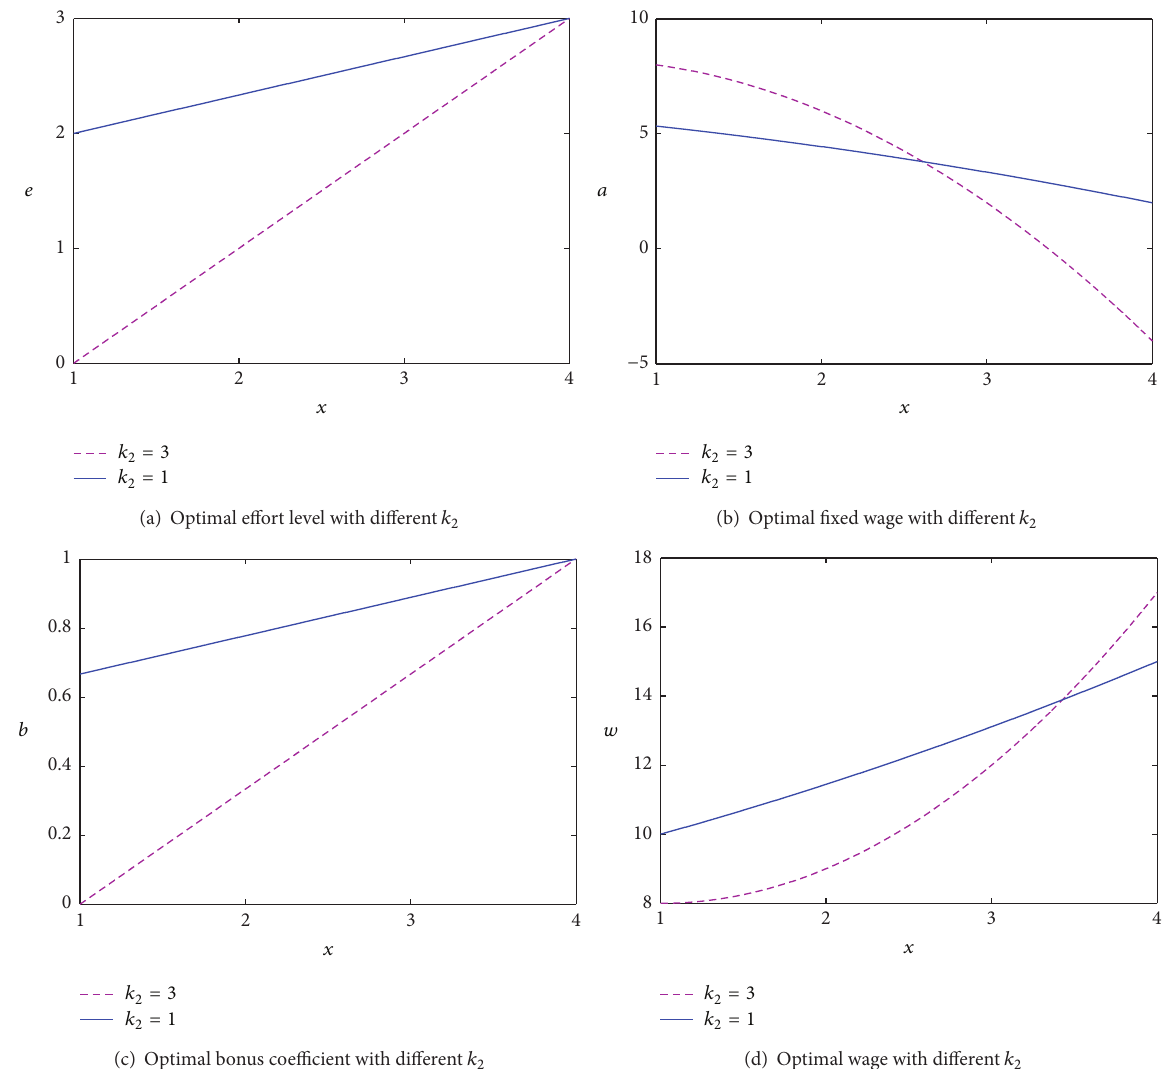
Figure 2: Optimal contract with different parameter 𝑘 2